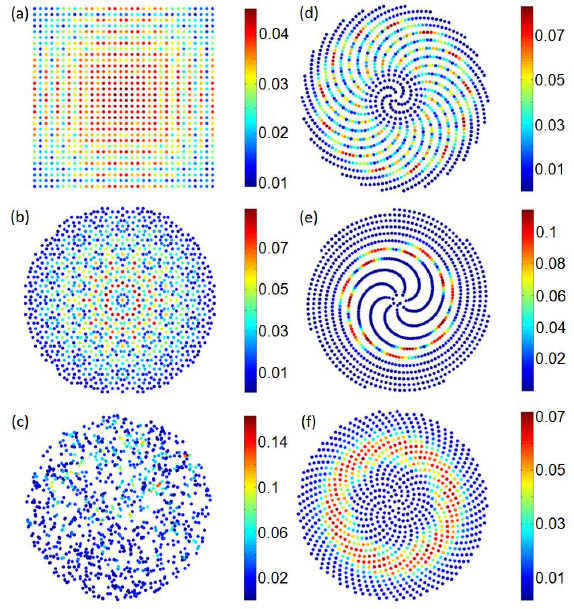
Figure 19. Example of long-lived ( Re (cid:39) − 1) eigenvectors with small IPR value in each case of ( a ) N = 1024 square array ( Λ = − 0.9323 − 1.9290 i , IPR = 0.0008 ) ; ( b ) N = 1108 Penrose array ( Λ = − 0.9963 − 1.0690 i , IPR = 0.003 ) ; ( c ) N = 1000 random array ( Λ = − 0.9091 − 8518 i , IPR = 0.0052 ) ; ( d ) N = 1000 µ -spiral array ( Λ = − 0.9995 + 0.9646 i , IPR = 0.0024 ) ; ( e ) N = 1000 π -spiral array ( Λ = − 1.0000 − 0.5143 i , IPR = 0.0064 ) ; and ( f ) N = 1000 τ -spiral array ( Λ = − 0.9896 − 0.4762 i , IPR = 0.002 ) . The S λ 2 values are all equal to 4.19 and color-coding is the vector norm of the eigenvector component ( x , y , z ) associated with each